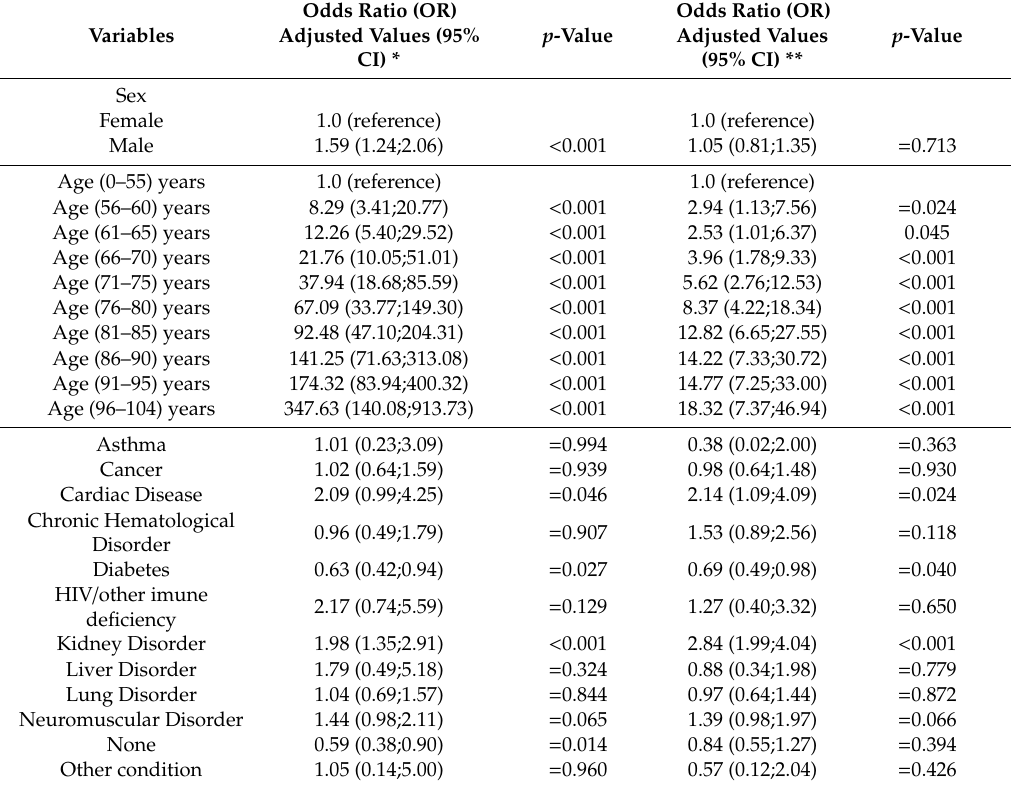
Figure 1. Forest plot illustrating the contribution of each co-factor for the overall model. Table 4. Complementary calculations to evaluate data robustness and model consistency: A multivariable model only including cases up to 31 March 2020 and a multivariable model for hospitalized cases .